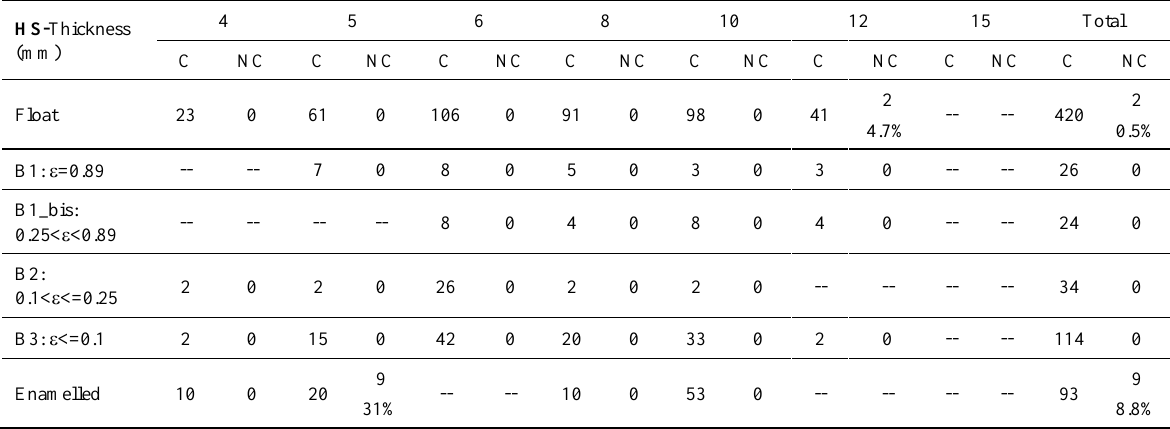
Table 4b. Number of HS tested for